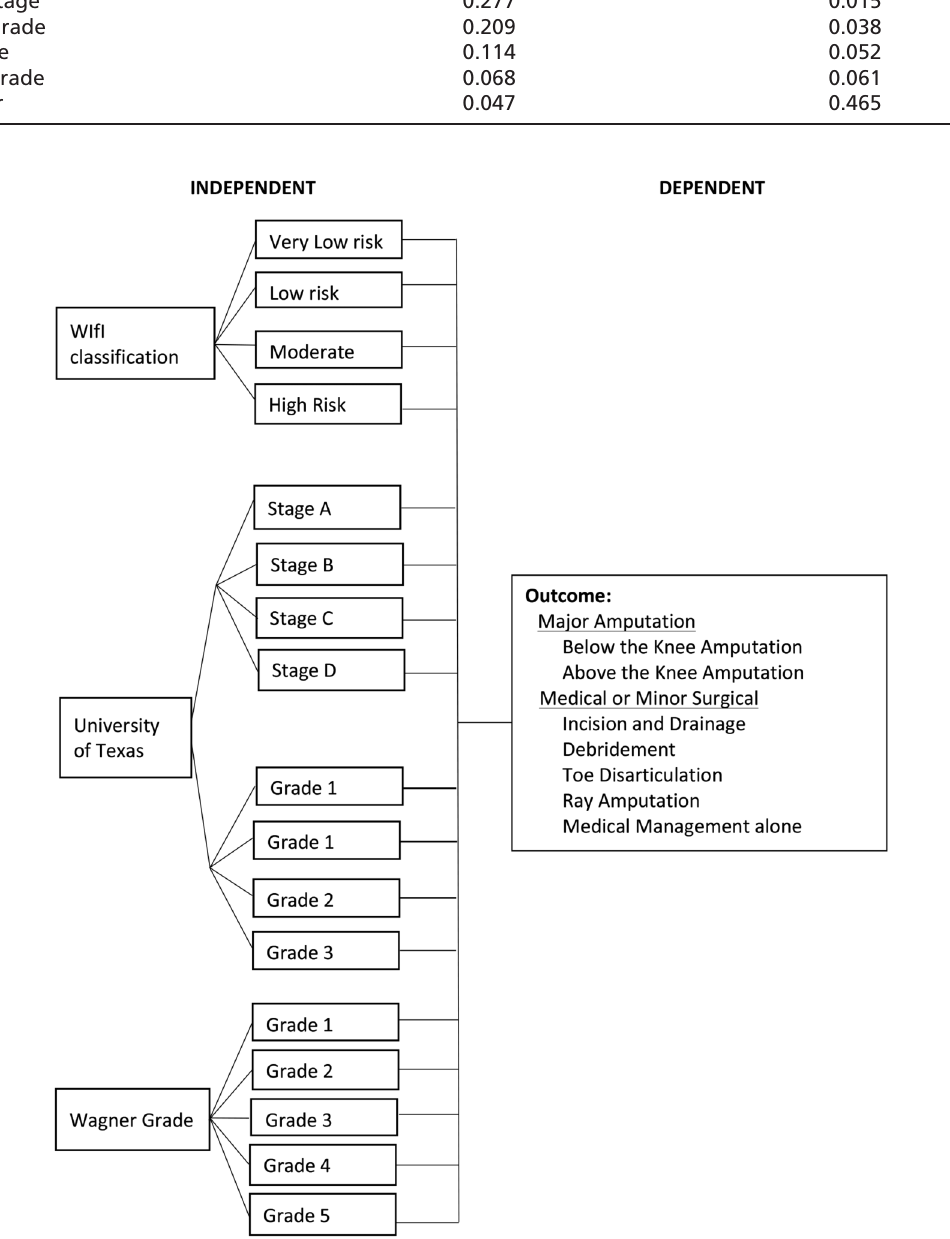
Conceptual Framework. Relationship Between Independent and Dependent Fig. 1: